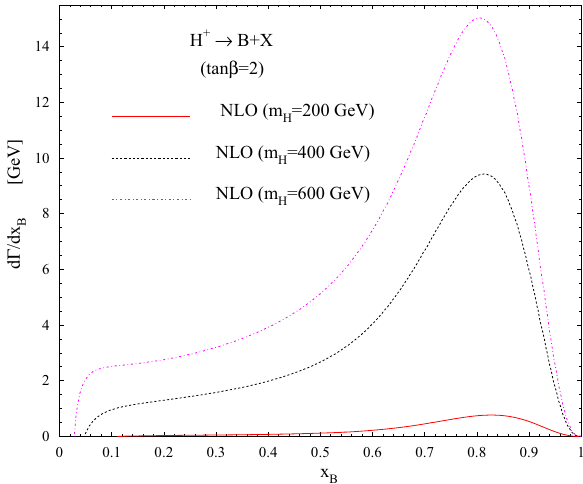
Fig. 2 d (cid:5)( H + → BX )/ x B as a function of x B in the 2HDM consid- ering different values of tan β = 1, 3 and 6. The mass of heavy charged Higgs is fixed to m H + = 200 GeV